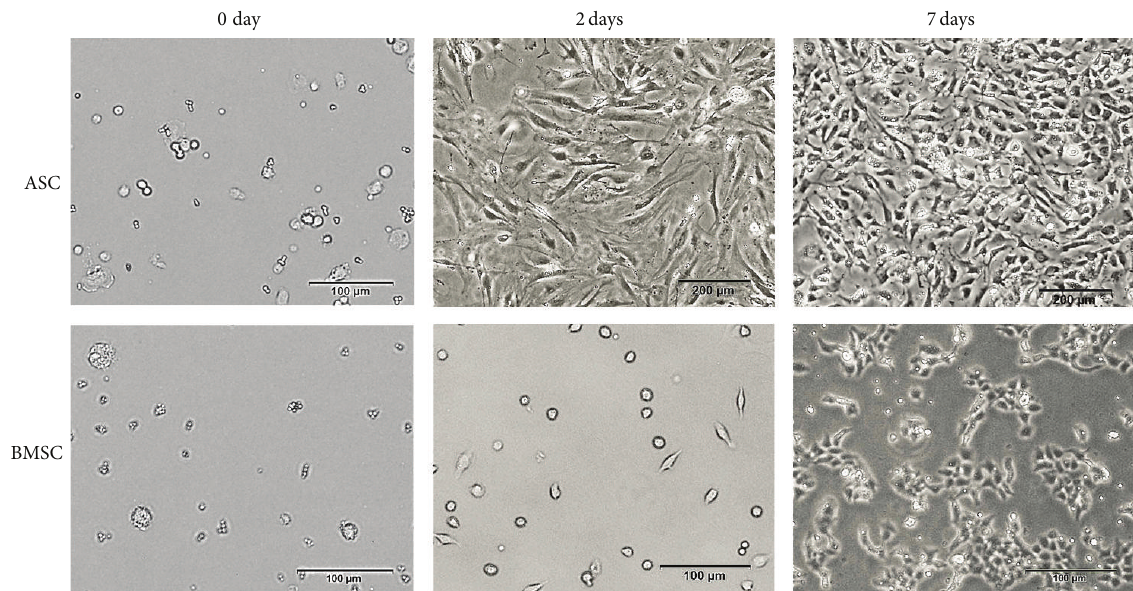
Figure 2: Expansion of ASCs and BMSCs. Cells from the second passage were cultured in 24-well plates at an initial cell number of 4 × 10 6